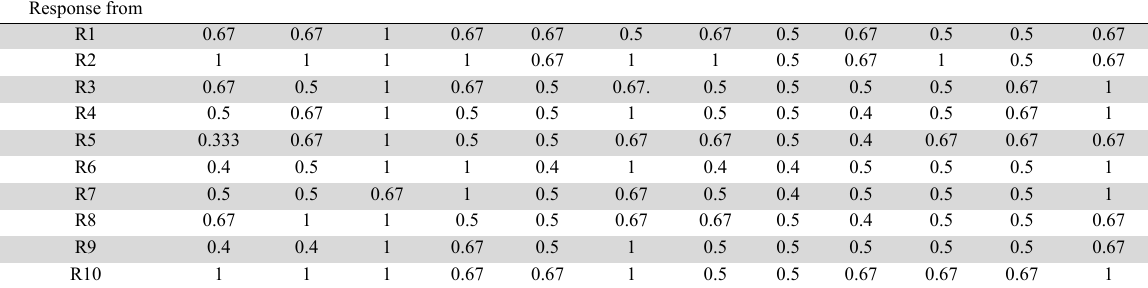
Calculated Grey Relational Coefficients Response